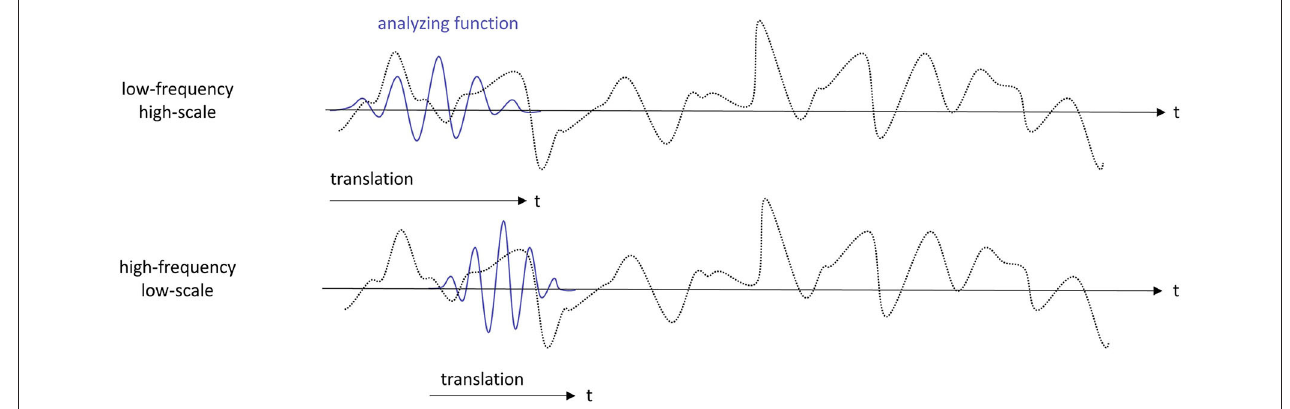
FIGURE 1 | Example of the analyzing wavelet function scaling and shifting across the time series that is being transformed. Equation (1) is the mathematical exposition of what is visualized in this